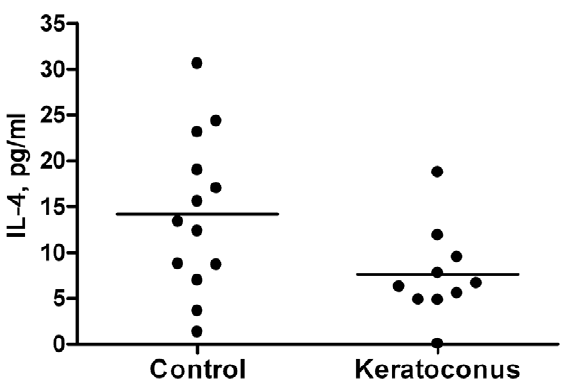
Figure 3. Increase in IL-17 measured by standard ELISA. Five pools of keratoconus and control subjects (Table S2) were used. Each ELISA value is an average of two measurements. The increase in IL-17 in keratoconus samples (72.5 6 59.2 pg/ml) compared to controls (18.5 6 7.8 pg/ml), was statistically significant (p # 0.05, Mann-Whitney test). The horizontal bar indicates the mean value for each